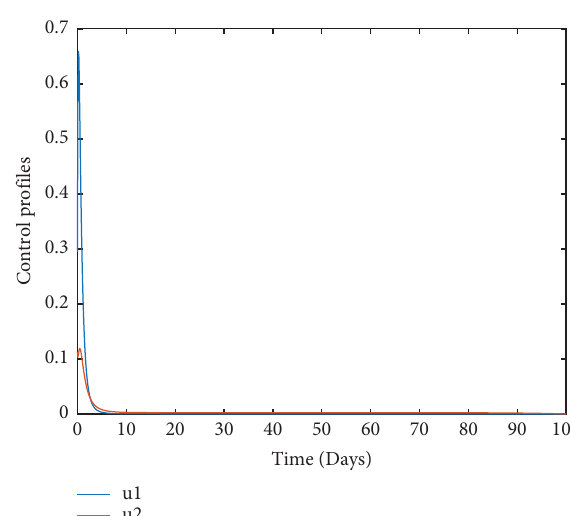
Figure 14: Diagram of the optimal solution u ∗